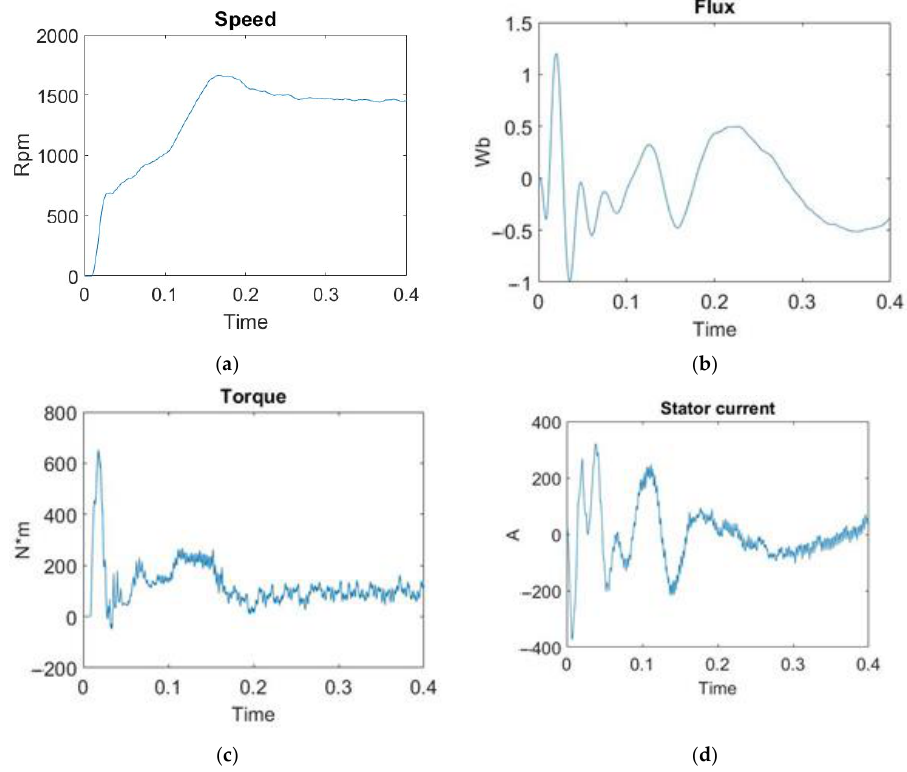
Figure 8. Output characteristics at nominal values: ( a ) speed; ( b ) flux; ( c ) torque and ( d ) current.